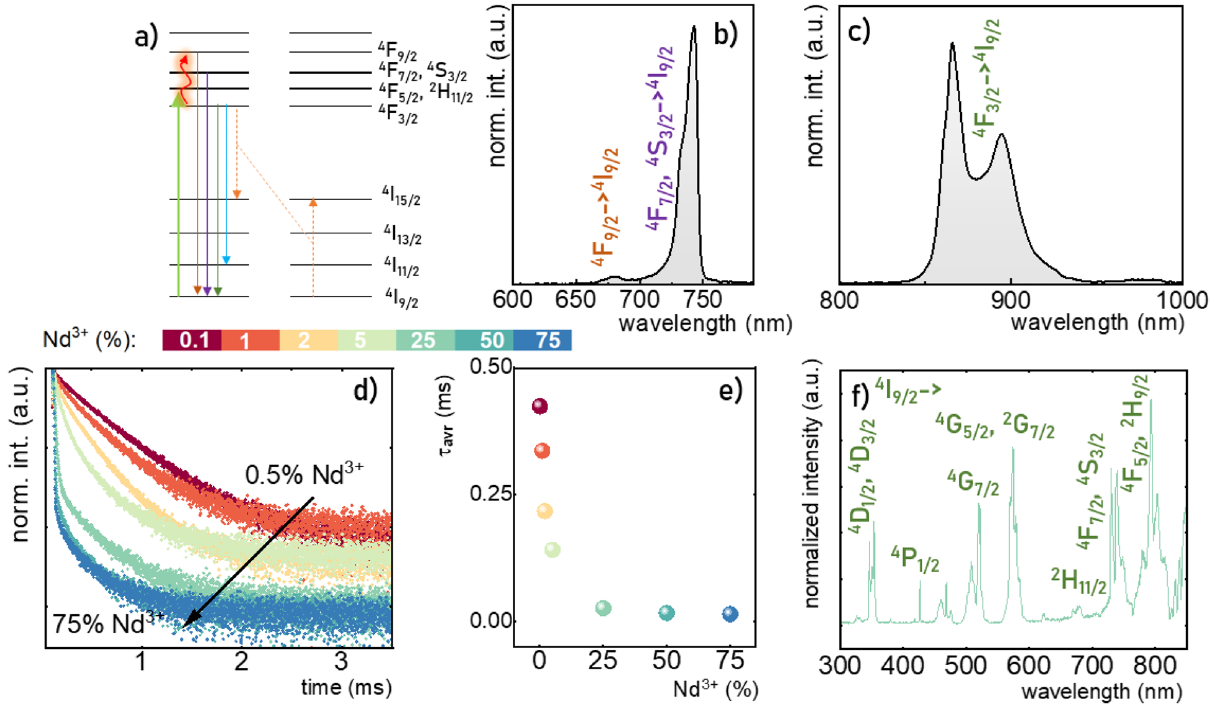
Figure 2. Simplified energy diagram of Nd 3+ ions ( a ); the representative Stokes ( b ) and anti-Stokes ( c ) emission spectra upon 808 nm excitation of the NaYF 4 :1%Nd 3+ nanoparticles; the luminescence decay profiles of the 4 F 4 F → 4 I 3/2 state (measured for 3/2 11/2 transition at 123 K) ( d ); the τ avr monitored at 123 K as a function of Nd concentration ( e ); and the representative excitation spectrum of NaYF 4 :1%Nd 3+ nanoparticles measured at 123 K ( f